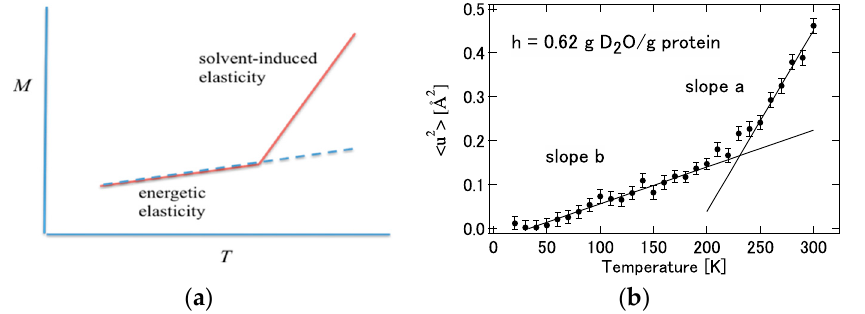
Figure 14. ( a ) Temperature dependence of the mean square displacement deduced from Equation (41). ( b ) Experimental results obtained by Nakagawa and Kataoka [102]. ((a) is reprinted from Ref. [25]. Copyright (2018) Elsevier. ( b ) is reprinted from Ref. [102]. Copyright (2010) Physical Society of Japan.).